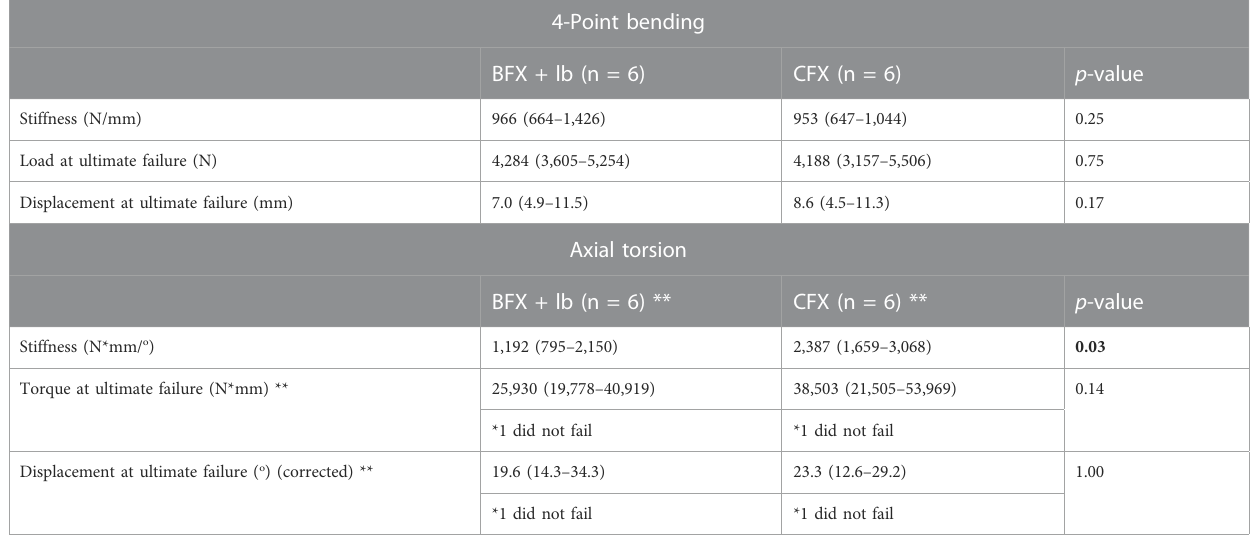
TABLE 3Resultsof 4-point bending test(top) andaxialtorsion test(bottom).Reported valuesaremedian (range). Thedegreesatultimatefailurewascorrectedto accountfor an initial toe region of the datathat implied a delay in the fi xture contacting the neck of the implant. Measurements were compared usinga Wilcoxon signed rank test. p < 0.05 was considered statistically signi fi cant. There was no difference in stiffness or failure between femora implanted with BFX + lb or CFX when subjected to 4-point bending, but femora implanted with CFX were stiffer than femora implanted with BFX + lb when subjected to axial torsion. **Only 5/ 6 femurs from each implant group (different pairs) failed during torsional testing so the reported p -values for load and displacement at failure was calculated using n = 4